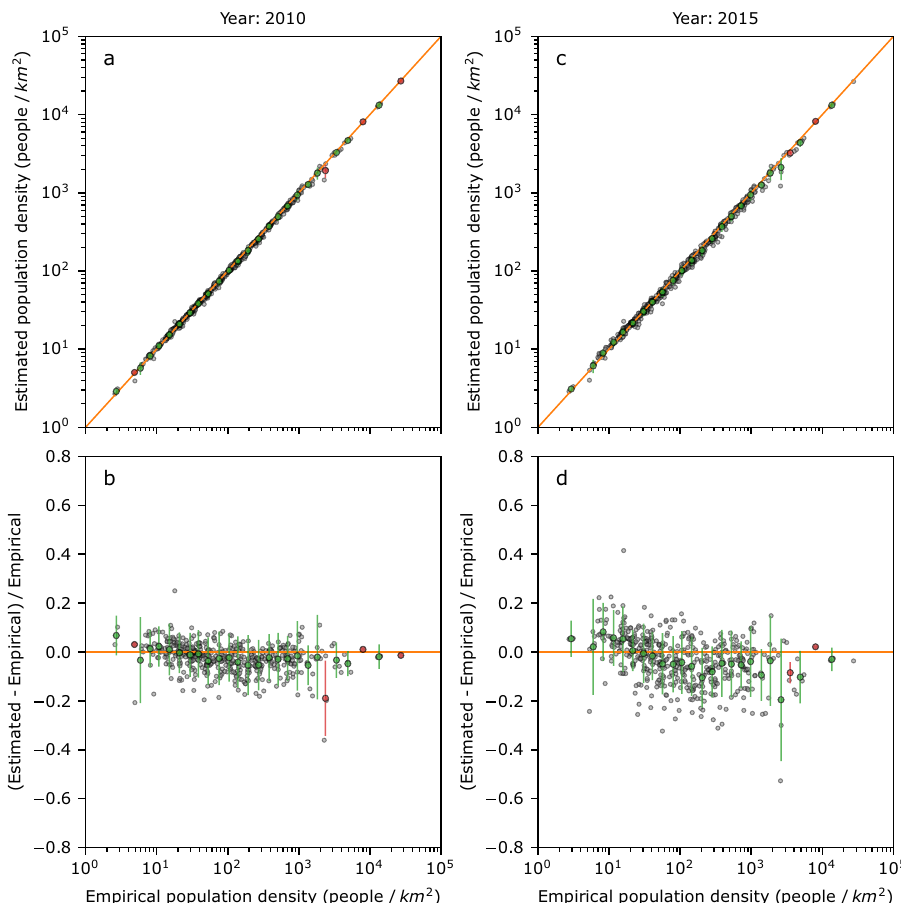
Fig. 3 Model with parameters given by their time-averaged values performs well at the system level. a , c The estimated population density as function of the empirical population density in 2010 ( a ) and 2015 ( c ) of the 469 counties belonging to the 46 cities under consideration. The model starts at 2005 with the population density of the counties in this year as initial condition. Each gray dot represents a county. The x -axis is binned, and the mean and the error bars are colored green if the line y = x lies within the 95% con fi dence interval, otherwise mean and error bars are colored red. b , d The relative error of the estimates. The population estimate for each county was averaged over 100 independent